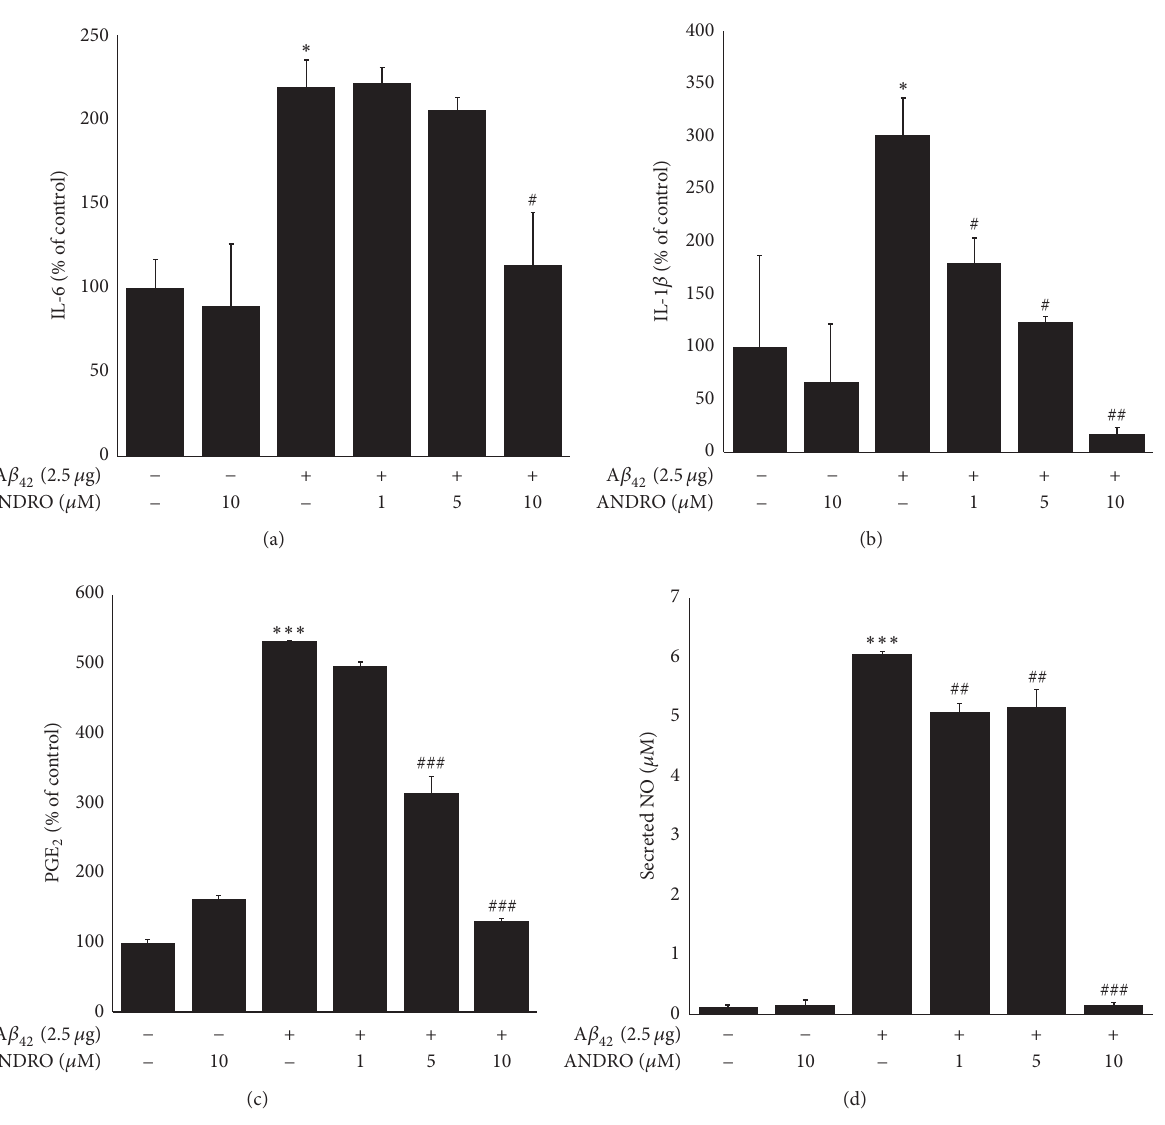
Figure 6: Effect of andrographolide on the secretion inflammatory cytokines, PGE 2 and NO. BV-2 cells were seeded onto culture dishes and transfected with A 𝛽 42 plasmids for 12h. Subsequently, the medium was replaced with fresh phenol red-free medium containing various concentrations of andrographolide for 24 h. The conditioned medium was collected and used to analyze the secretion of IL-1 𝛽 , IL-6, PGE 2 , and NO. The abbreviation of andrographolide, ANDRO, was used. The data are presented as the means ± SE of triplicates. The significance presented as ∗ 𝑝 < 0.05 and ∗∗∗ 𝑝 < 0.001 compared with control group and # 𝑝 < 0.05 , ## 𝑝 < 0.01 , and ### 𝑝 < 0.001 compared with the A 𝛽 42 -transfected